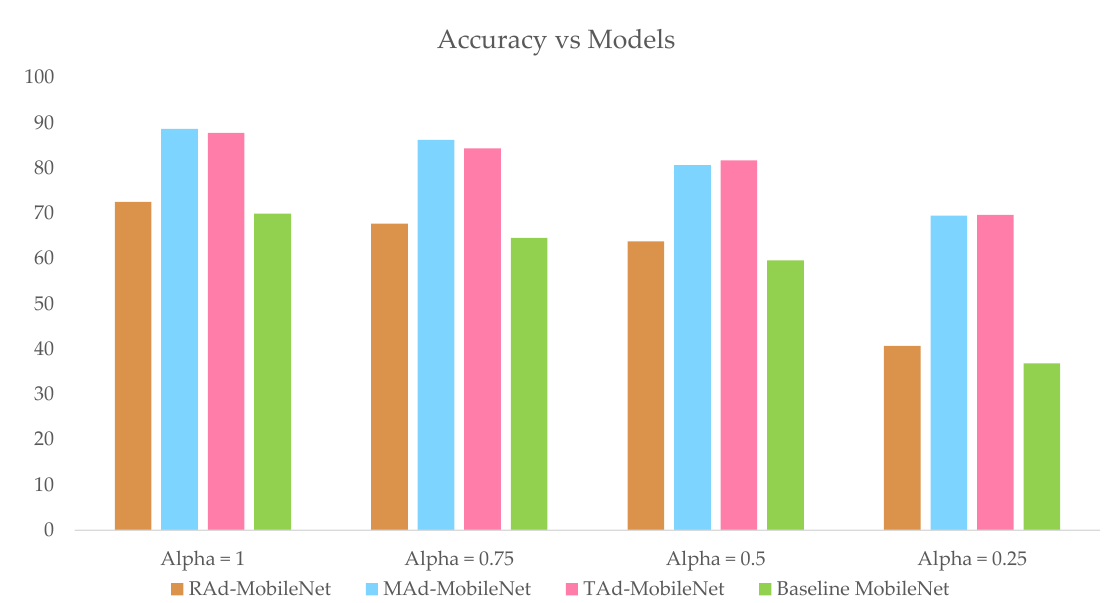
Figure 17. Comparison of the model performance based on the top-1 test accuracy for varying the width multiplier.